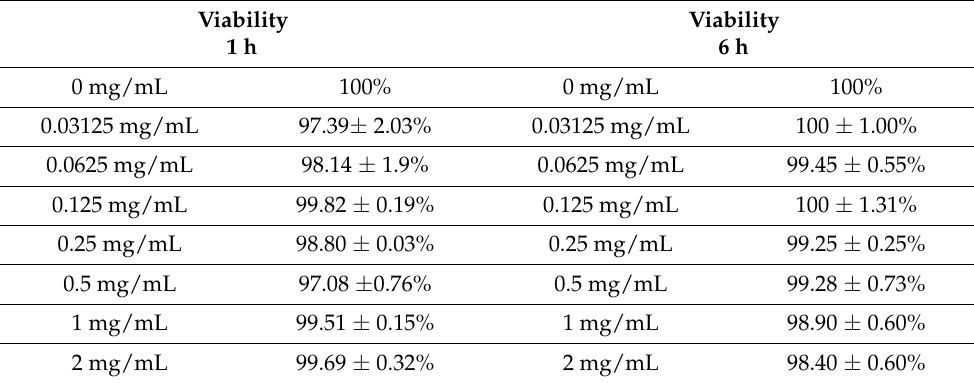
Table 4. Cell viability on TK6 cells after 1 h or 6 h treatment with the SMD at the indicated concentra- tions compared to the concurrent negative control (0 mg/mL). Each value represents the mean ± SEM of three independent experiments.